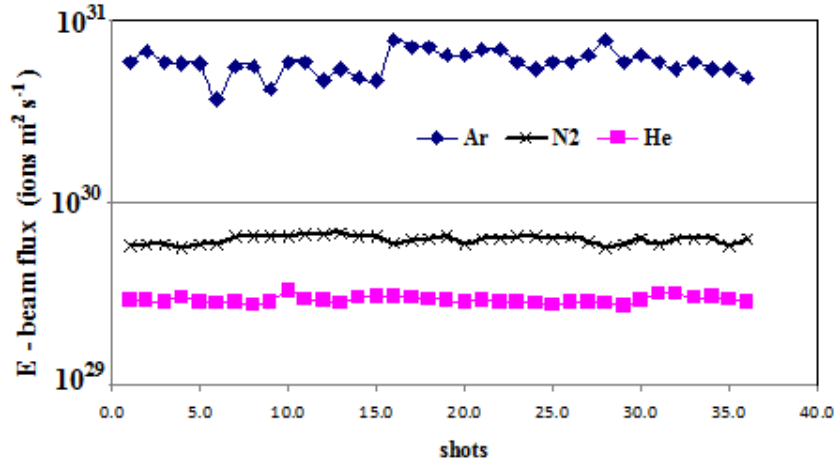
Figure 7. AECS PF-1 electron beam flux for 36 shots at 0.6 Torr for He, N 2 , and Ar gases.